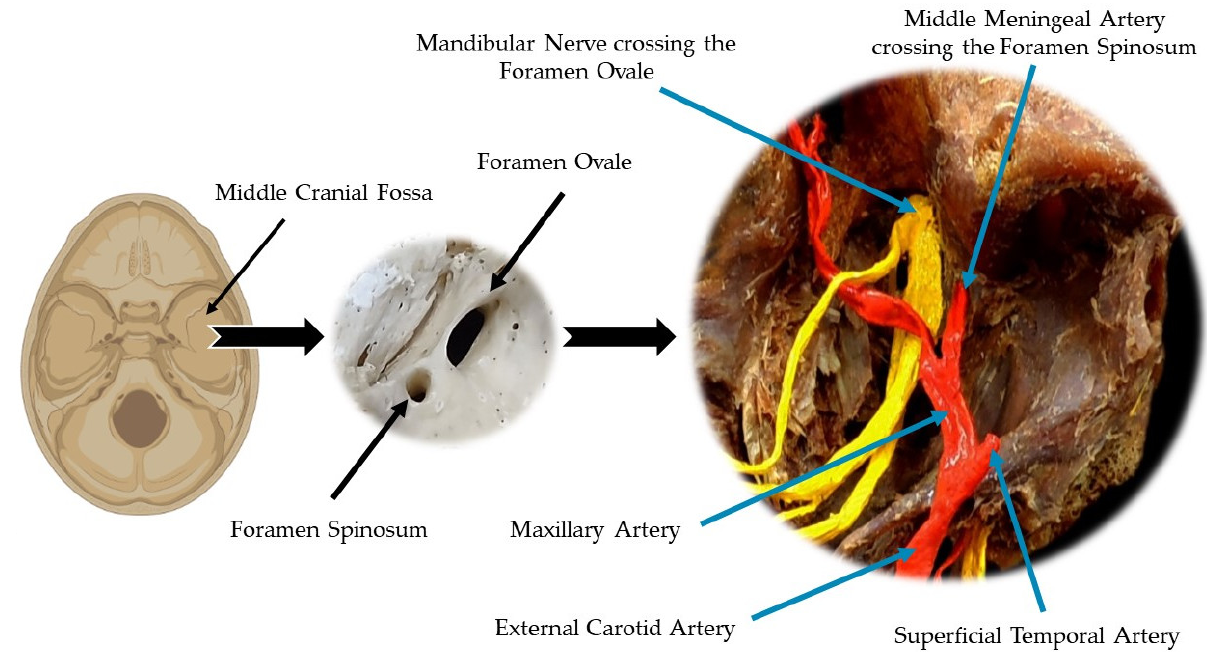
Figure 1. The greater wing of the sphenoid bone is one of the main bone constituents of the middle cranial fossa that, among its various anatomical features, presents the spinous foramen and the foramen ovale. When located close to the temporomandibular joint (TMJ), the external carotid artery gives off its terminal branches, including the superficial temporal artery and the maxillary artery. The maxillary artery can be divided into four portions: mandibular, muscular, maxillary, and pterygopalatine. In the first portion, the mandibular, located in the infratemporal or zygomatic fossa, gives off the middle meningeal artery, which penetrates the skull through the spinous foramen. The mandibular nerve, functionally classified as a mixed nerve, crosses the foramen ovale and distributes its branches in the infratemporal fossa.